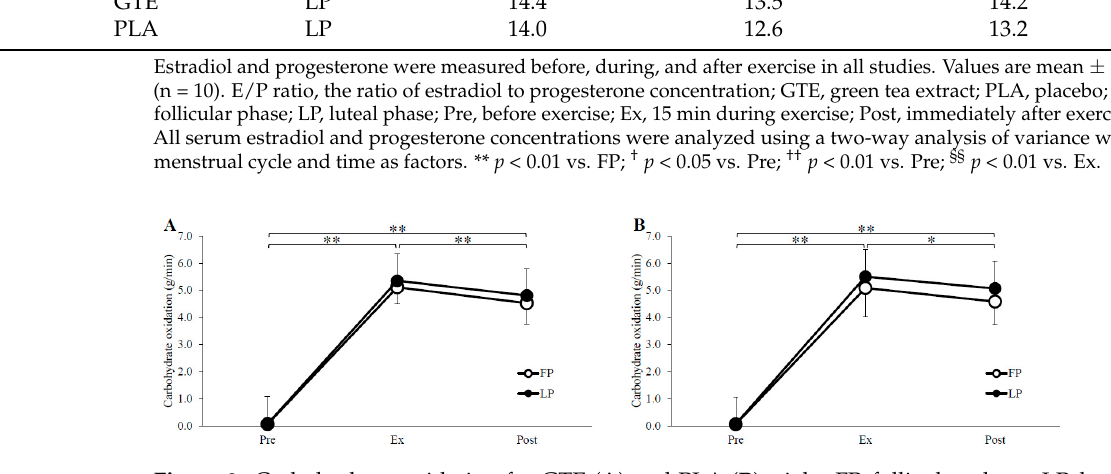
Figure 2. Carbohydrate oxidation for GTE ( A ) and PLA ( B ) trials. FP, follicular phase; LP, luteal phase; Pre, before exercise; Ex, 15 min during exercise; Post, immediately after exercise. * p < 0.05, ** p < 0.01.